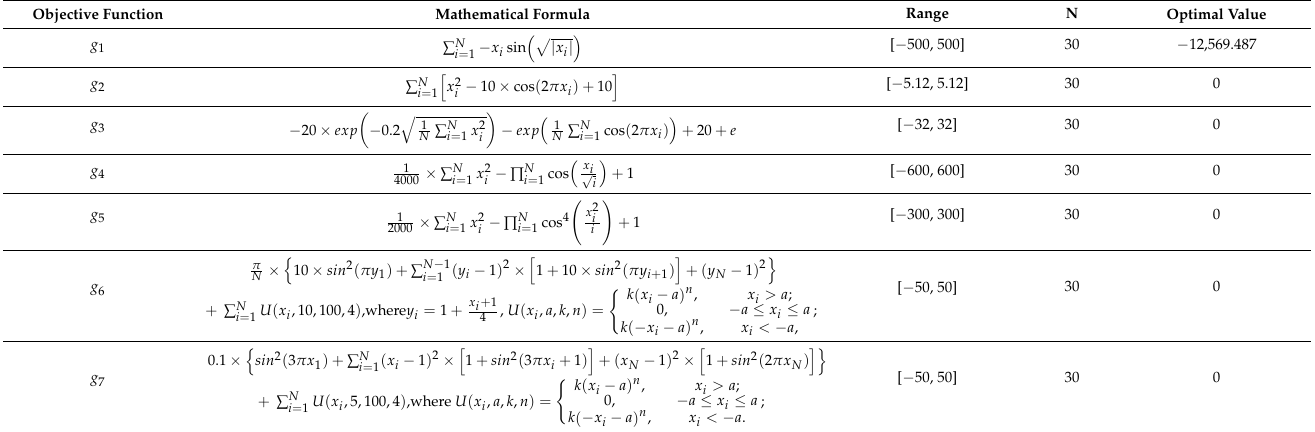
Table 3. High-Dimensional Multi-Objective Functions (Objective Functions g 1 − g 7 ).